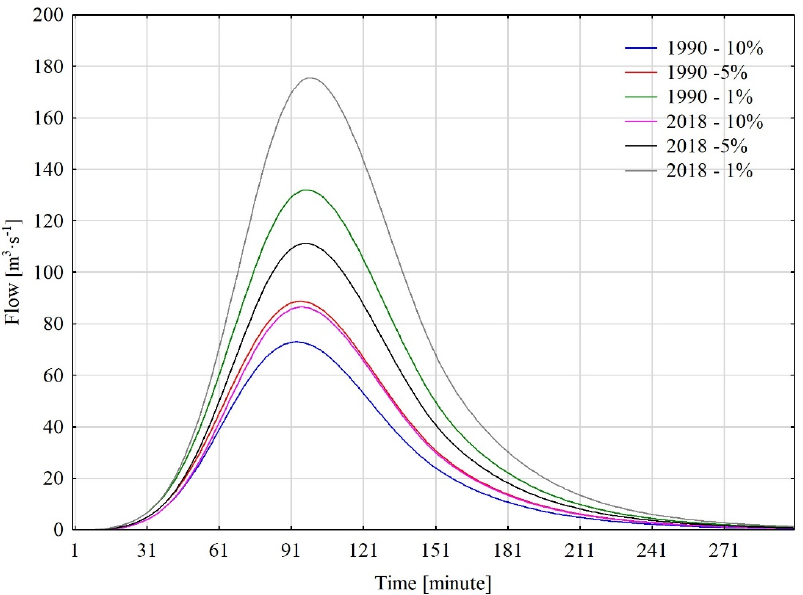
Figure 9. Simulated hydrograph for years 1990 and 2018 with different probabilities of precipitation.